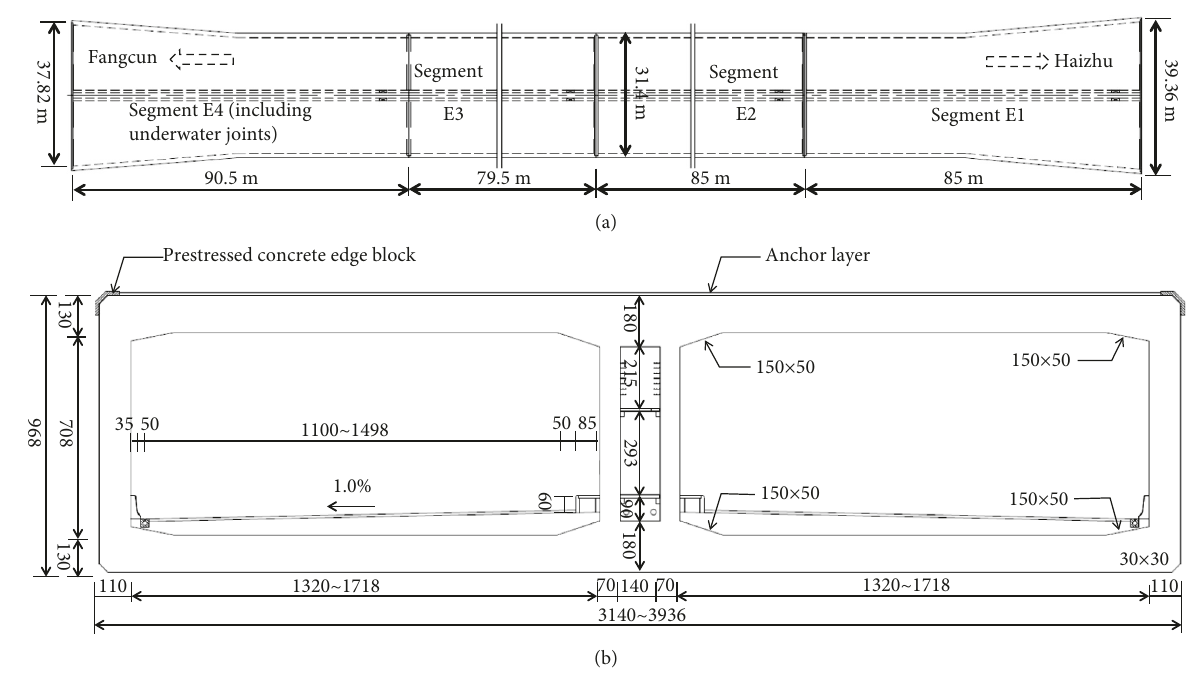
Figure 1: The overall design of the Zhoutouzui tunnel: (a) the tunnel plan; (b) the segment cross section, including the